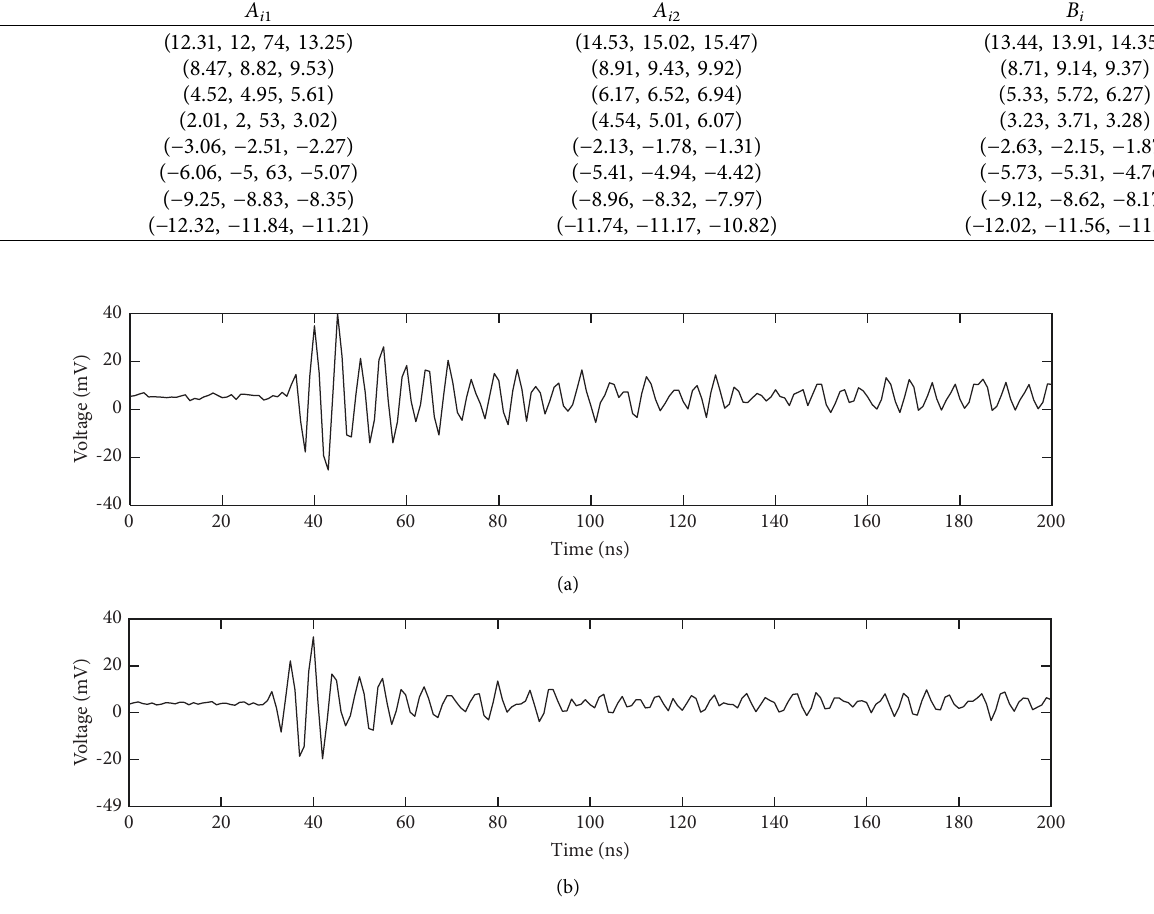
Figure 4: The collected PD UHF pulse signals with a 1GHz sampling rate. (a) Antenna A received PD UHF pulse signals. (b) Antenna B received PD UHF pulse signal. Figure 2. The received PD UHF signals are interpolated by